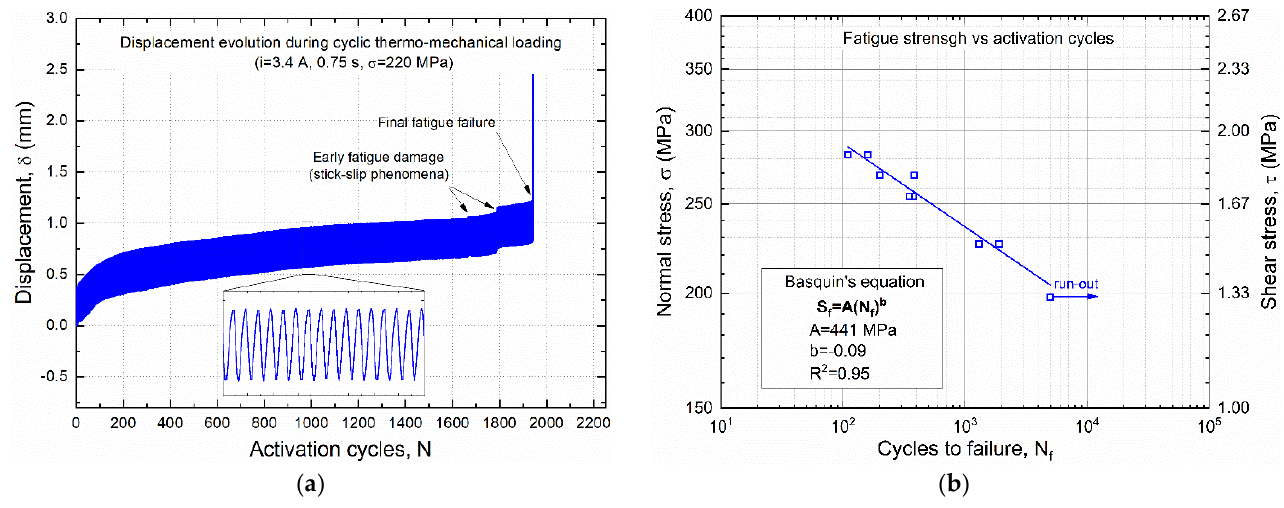
Figure 17. Thermo-mechanical fatigue of SMA – polymer samples: ( a ) evolution of the displacement vs. number of cycles under cyclic thermal activation (i = 3 A, t = 0.75 s) and a constant mechanical stress σ = 225; ( b ) Stress vs Cycles to failure (S--N) fatigue curve.